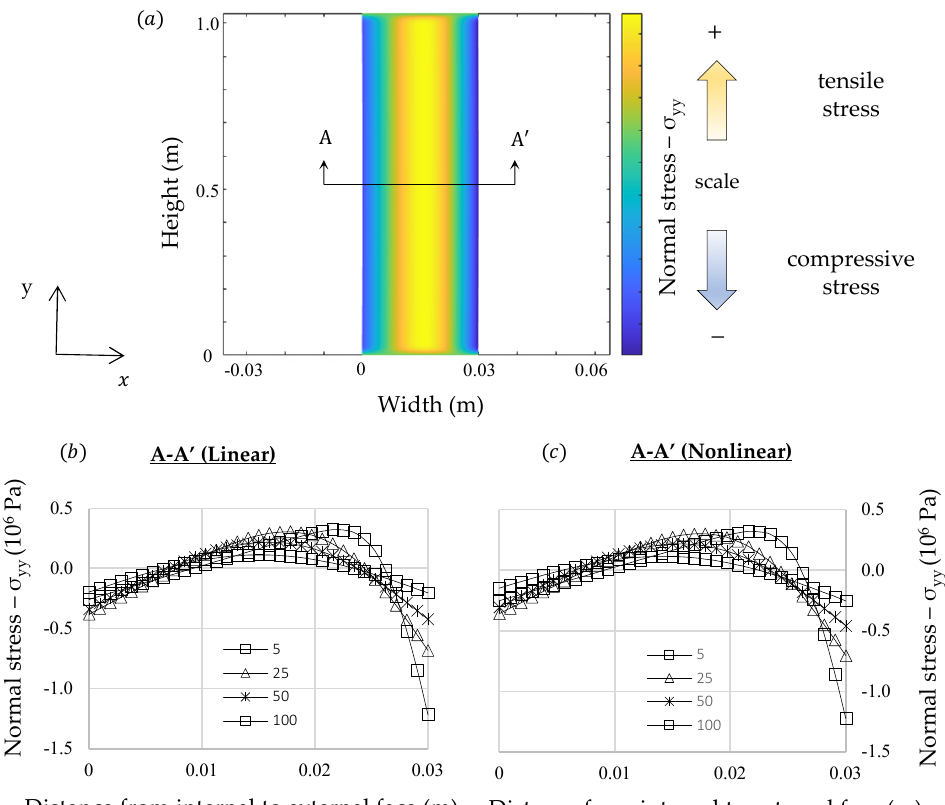
Figure 5. Comparison between linear and nonlinear numerical analysis of σ yy : (a) Representation of a generic normal stress distribution (b) linear analysis (c) nonlinear analysis.